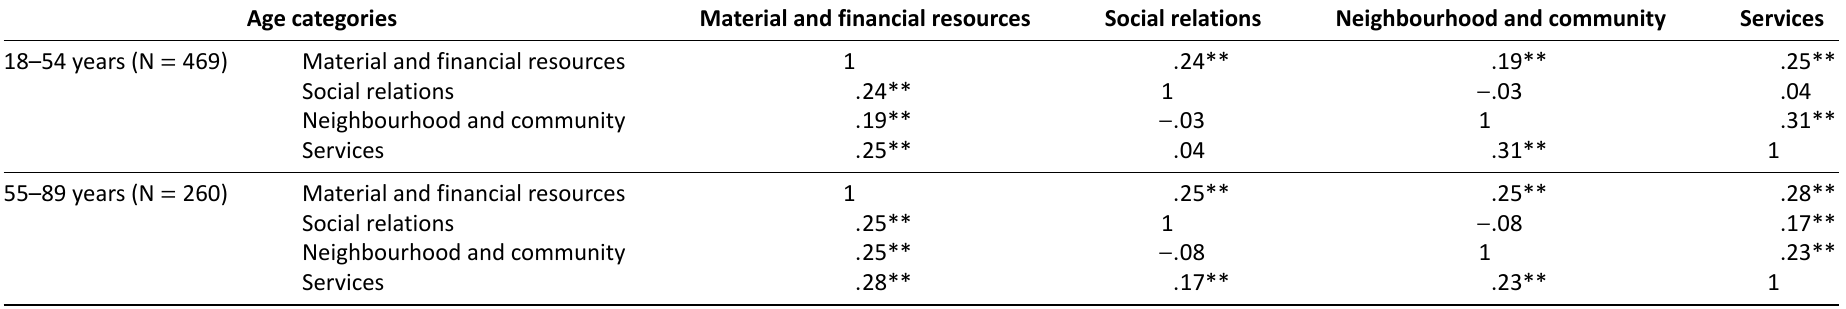
Table A3. Correlation between dimensions of social exclusion (summative